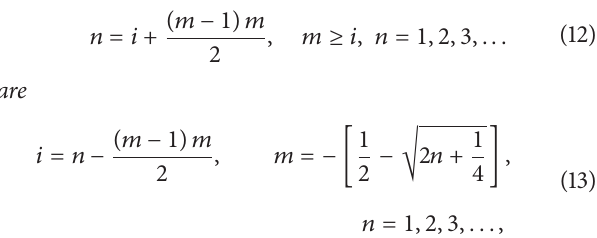
algorithm for solving split common fixed problem of